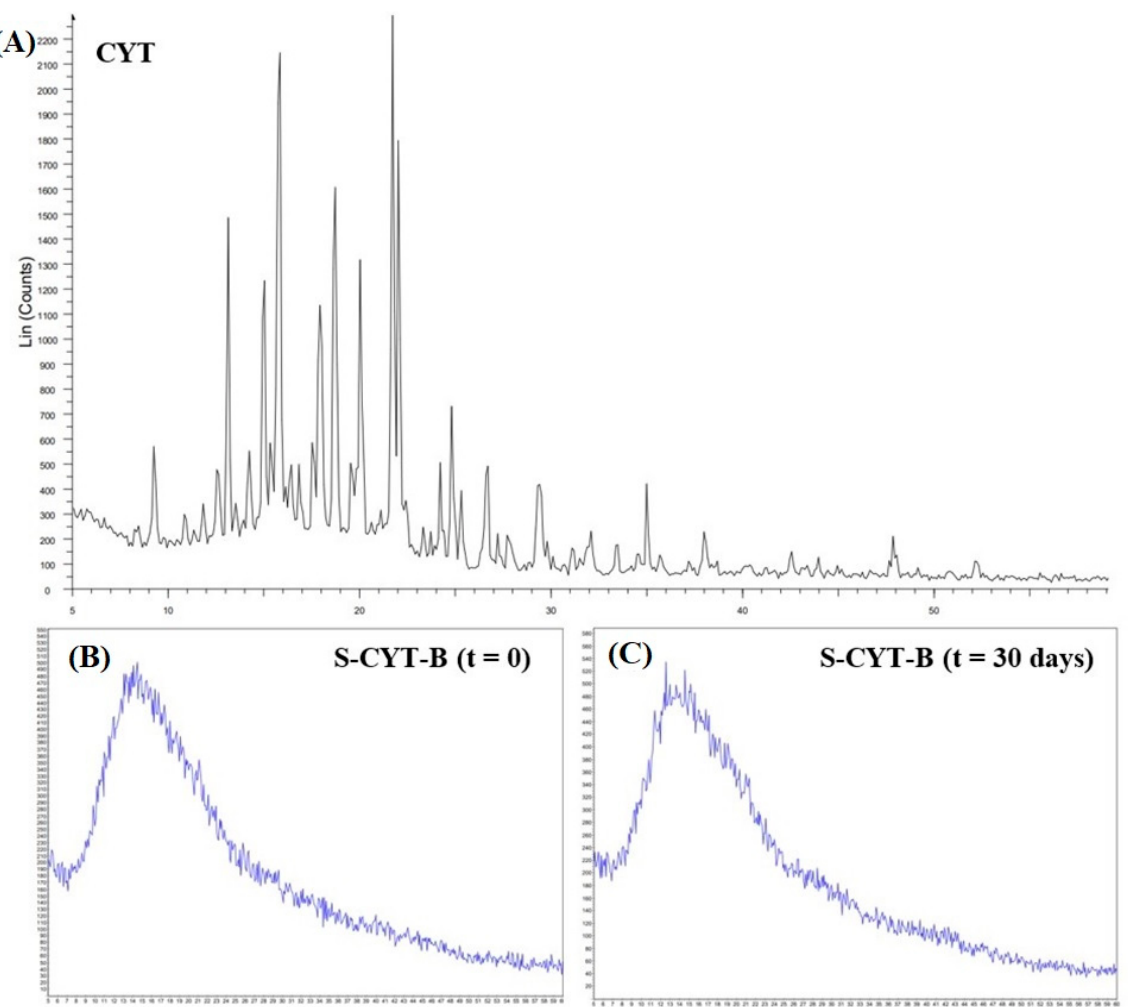
Figure 4. X-ray diffraction patterns of ( A ) pure CYT, ( B ) S-CYT-B powder immediately after prepara- tion and ( C ) S-CYT-B powder after 30 days storage. S-CYT-B spray-dried powder was reported as a representative example for all the prepared powders.